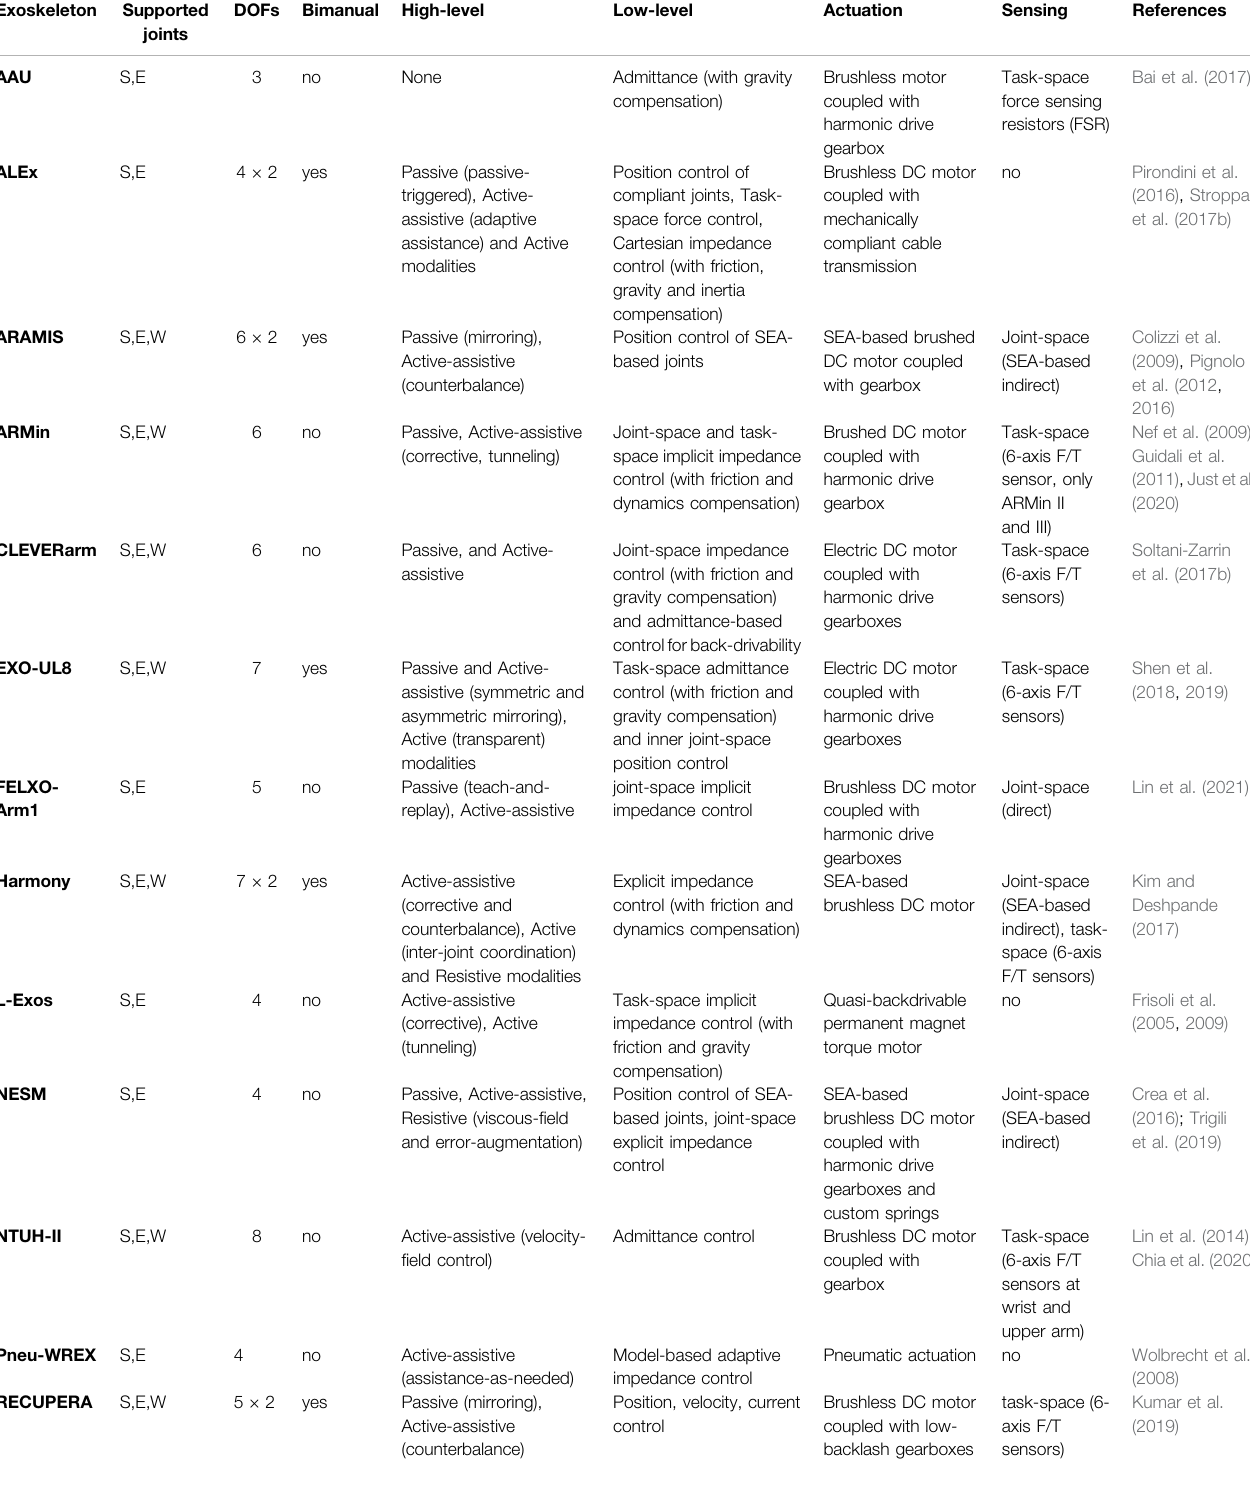
TABLE 3 | Comparison of available control strategies at high-level, low-level and hardware-level for upper-limb neurorehabilitation exoskeletons. S : shoulder, E : elbow, W : wrist.